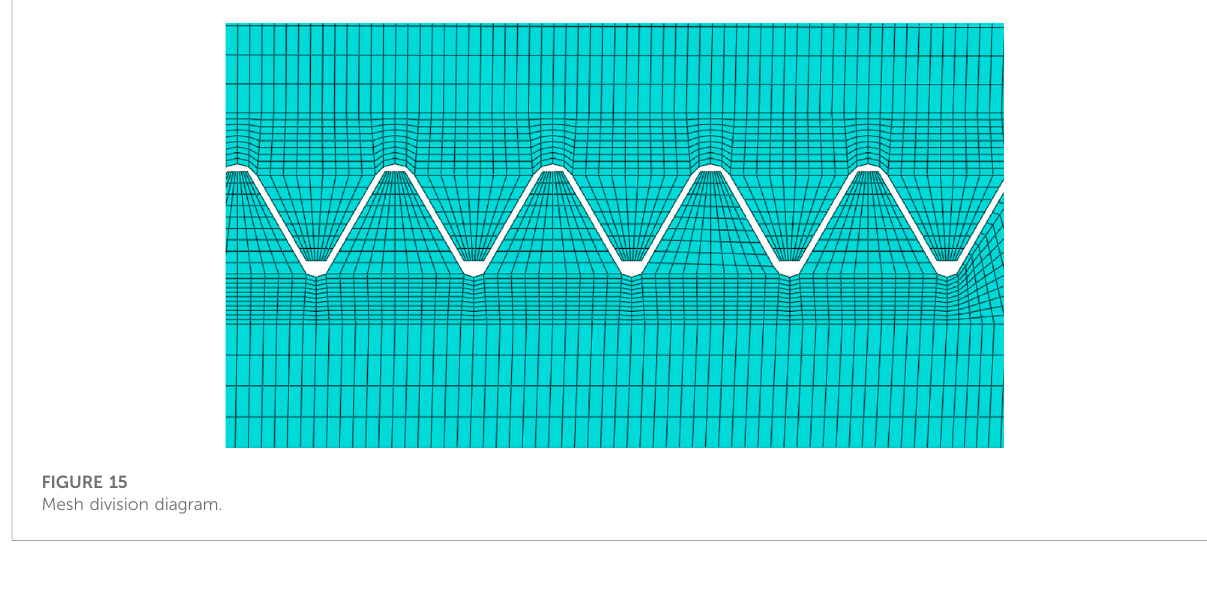
FIGURE 15 Mesh division